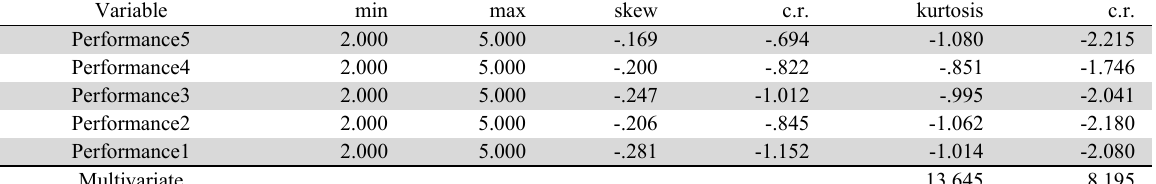
Assessment of normality (Group number 1) Performance Variables